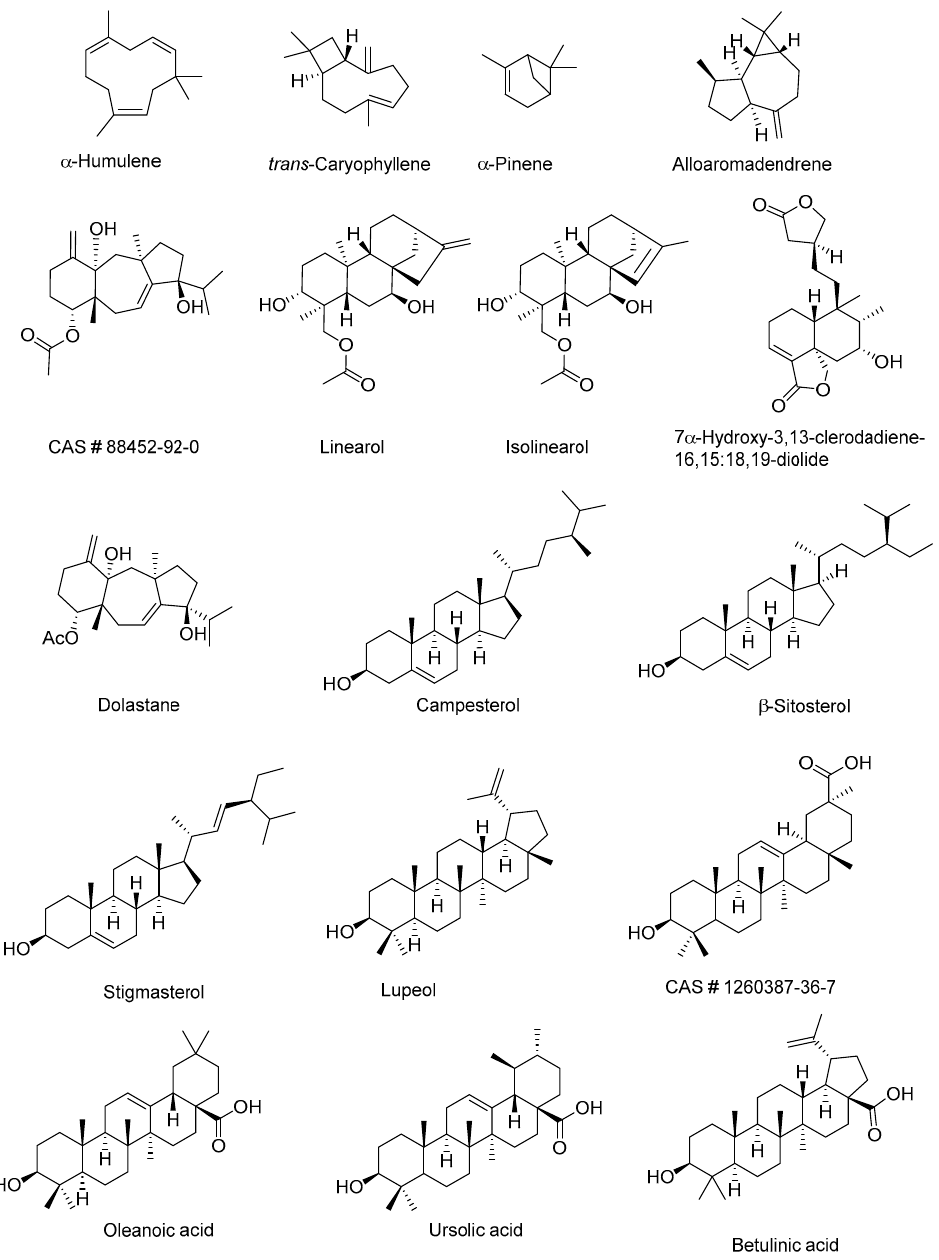
Figure 4 . Selected terpenoids with antivenom activity . Figure 4. Selected terpenoids with antivenom